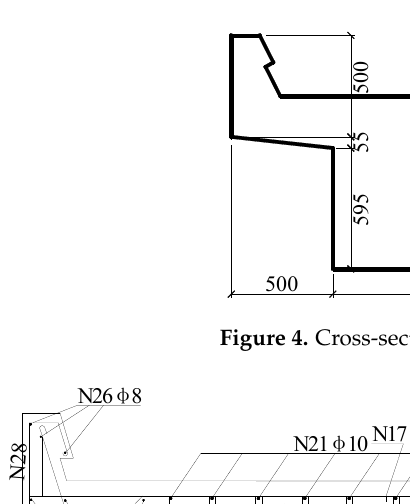
beam. The detailing of sensors is shown in Figure 6. The parameters of sensors used in the test are shown in Table 2. Figure 7 shows the field test. Table 2. Parameters of sensors. Name ( b ) Figure 7. Field test. ( a ) Installation of the test beam; ( b ) loading with jacks. Before the start of the test, preloading is carried out to eliminate the gap between the test beam and equipment. The grading loading method is adopted, and the load in- crement of each stage is about 10 percent of the estimated ultimate bearing capacity. Each level of load is held for 5 min, and then the test data of sensors is recorded. 4.3. Comparison between Model and Experimental Data